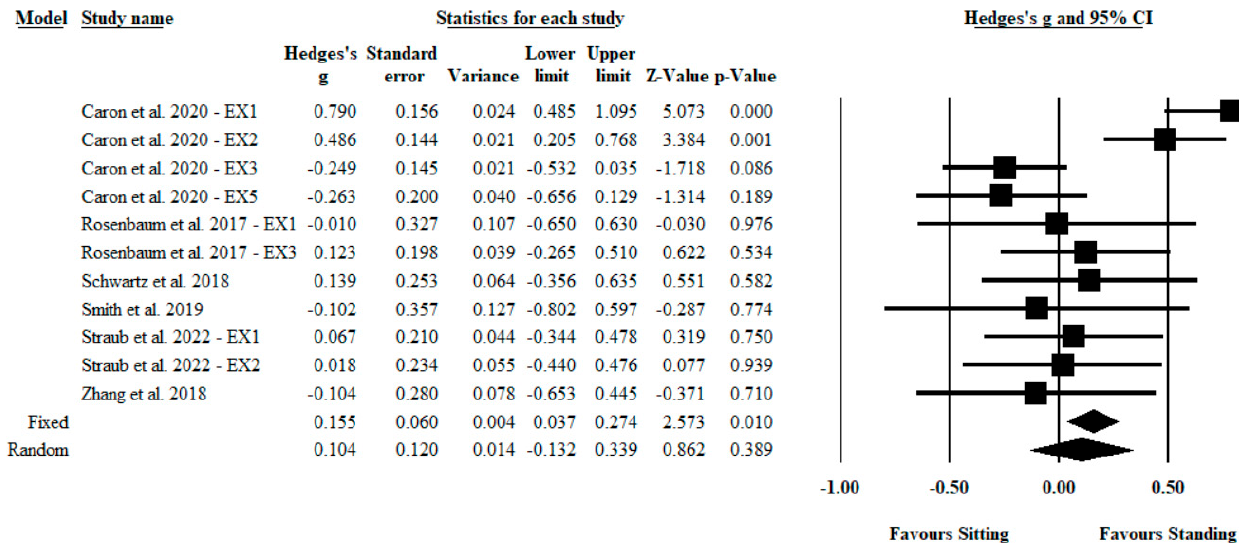
Figure 4. Forest plot of the Hedges’ g differences between sitting and standing conditions for incongruent stimuli.